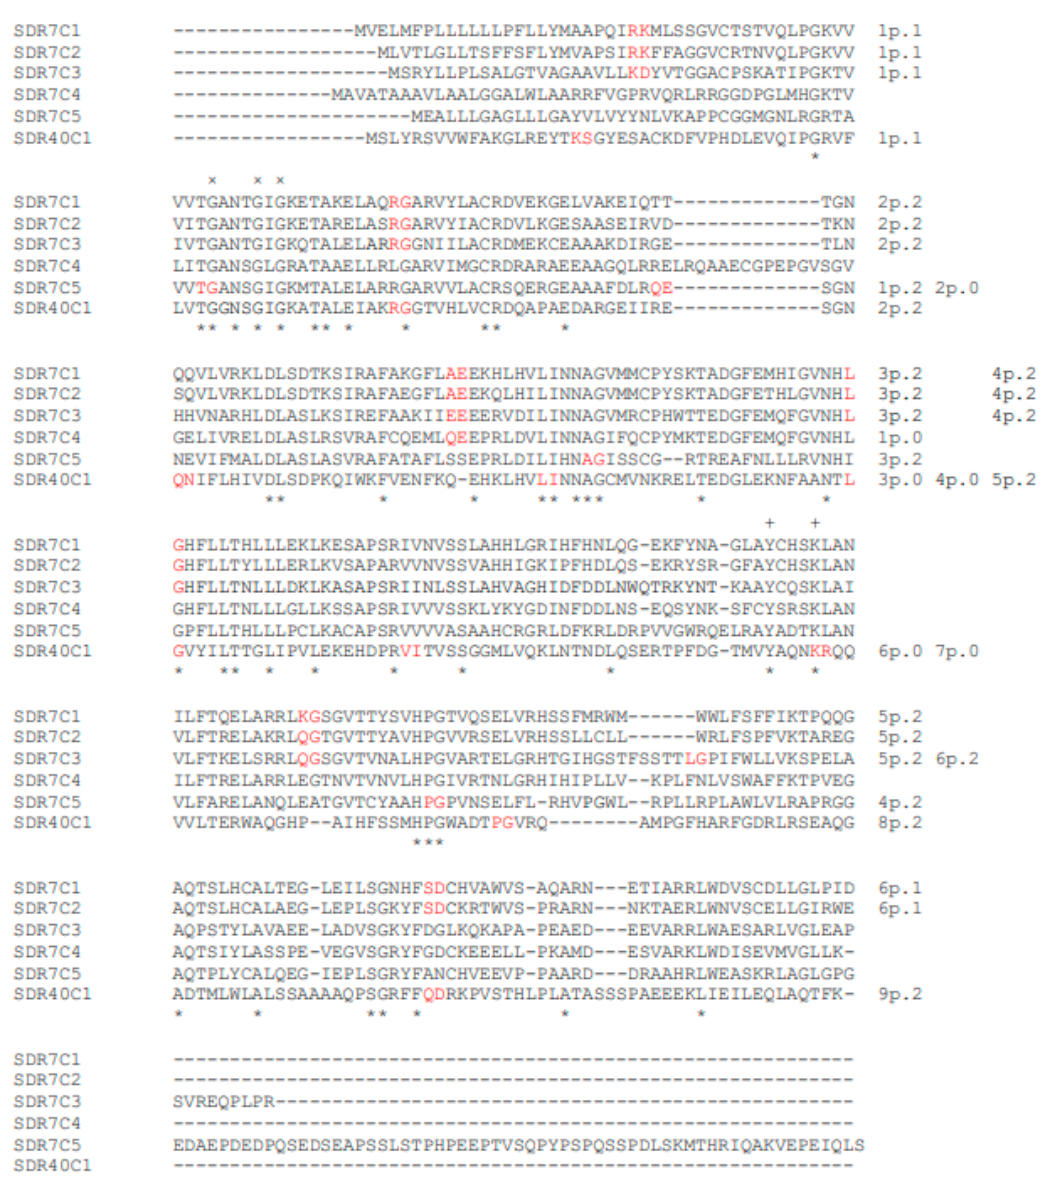
Figure 1. Alignment of the human SDR7C family and SDR40C1 protein variants. × and + symbols mark the structure consensus and the catalysis consensus respectively. The couples of amino acid symbols in red mark the splicing-site positions. Splicing sites are progressively numbered, and phase (p.) type is indicated after the splicing-site number. * symbol marks the position of identical amino acid residues of the aligned SDR protein